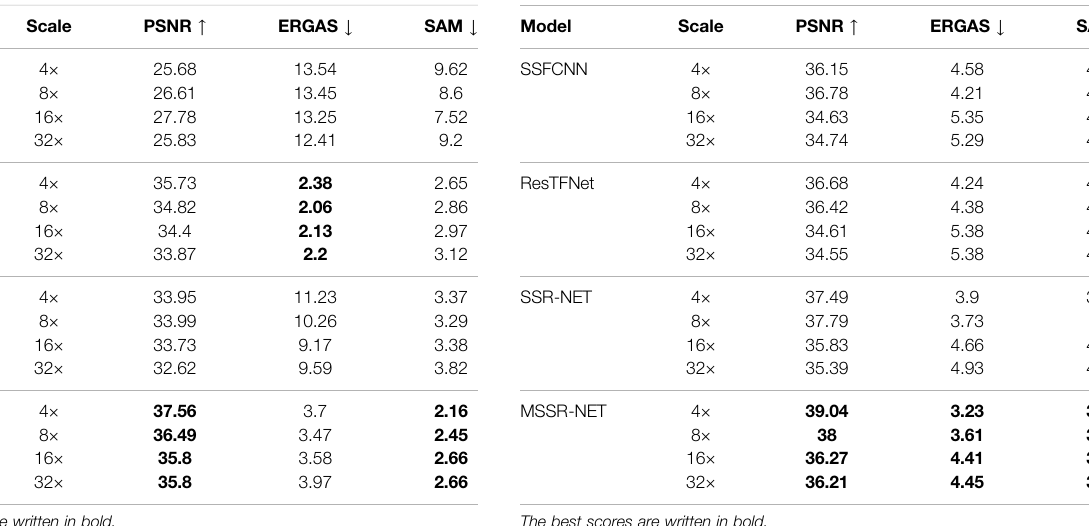
TABLE 5 | Quantitative results on Pavia Center dataset. HR MSI is generated according to Type 1 model.